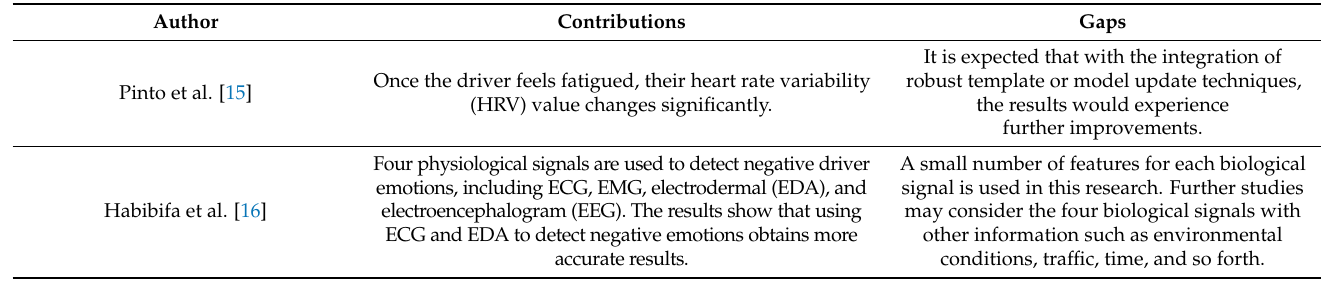
Table 1. Some researches on physiological signal identification of dangerous driving